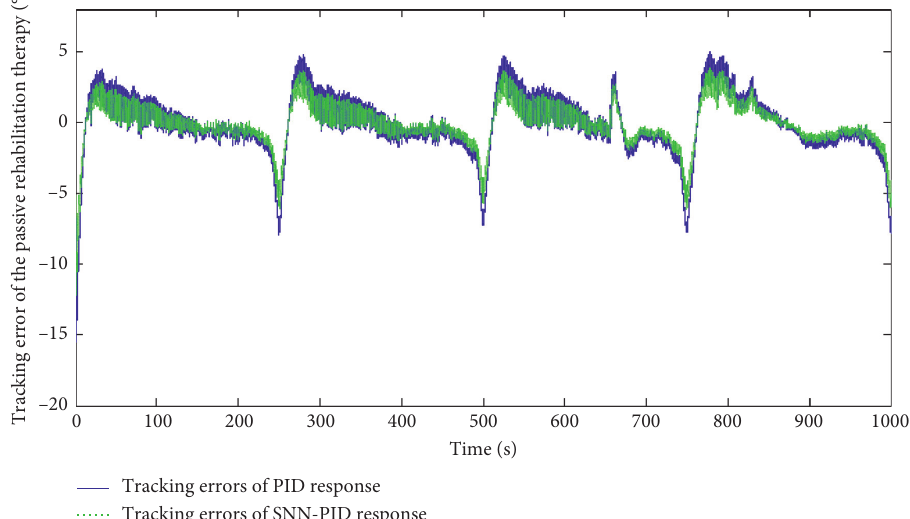
Figure 12: Tracking errors of passive rehabilitation therapy experiment under a half sinusoidal wave excitation of 0.004Hz with amplitude 50 °